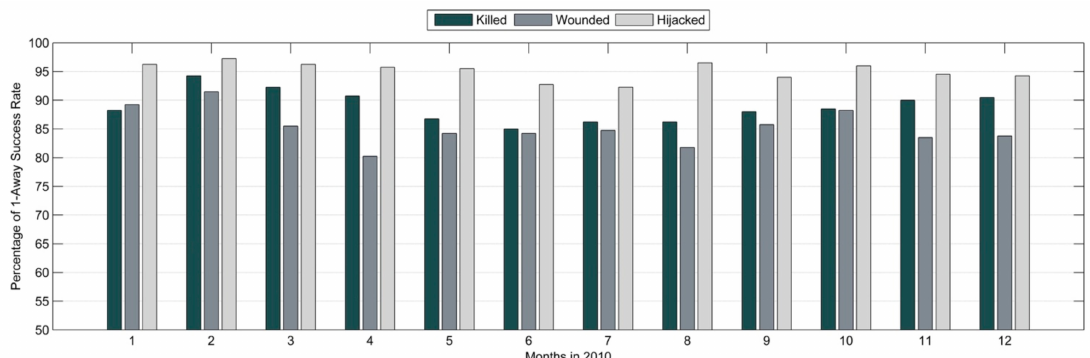
Figure 6. Percentage of one-away success rate per month in